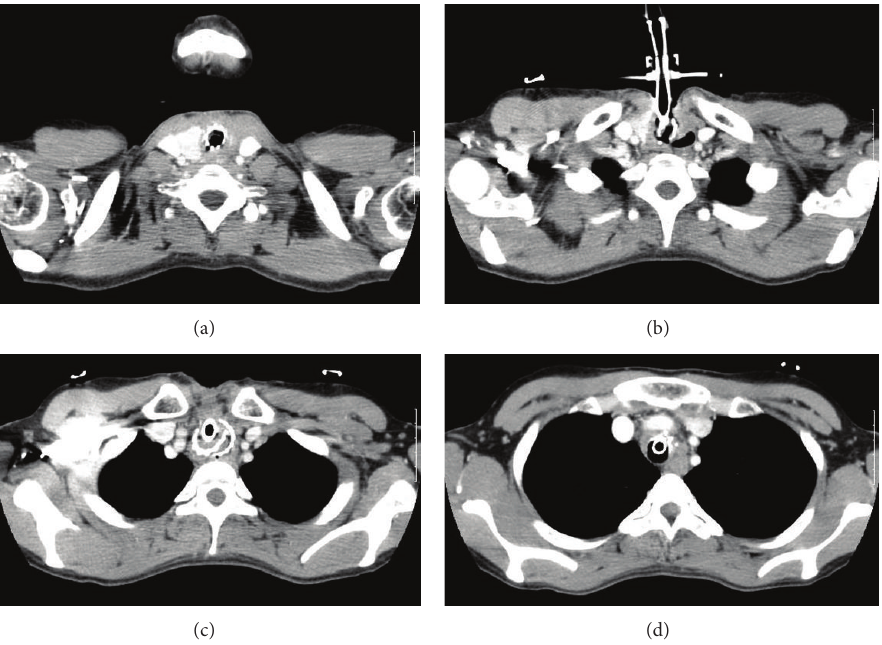
Figure 1: Computed tomography scans. (a) The stent was inserted proximally to the tracheotomy. (b) The tracheotomy was shown on CT. (c) The part of the destroyed stent that was distal from the tracheotomy was not circular. (d) The lower end of the stent was shown on the CT scan.